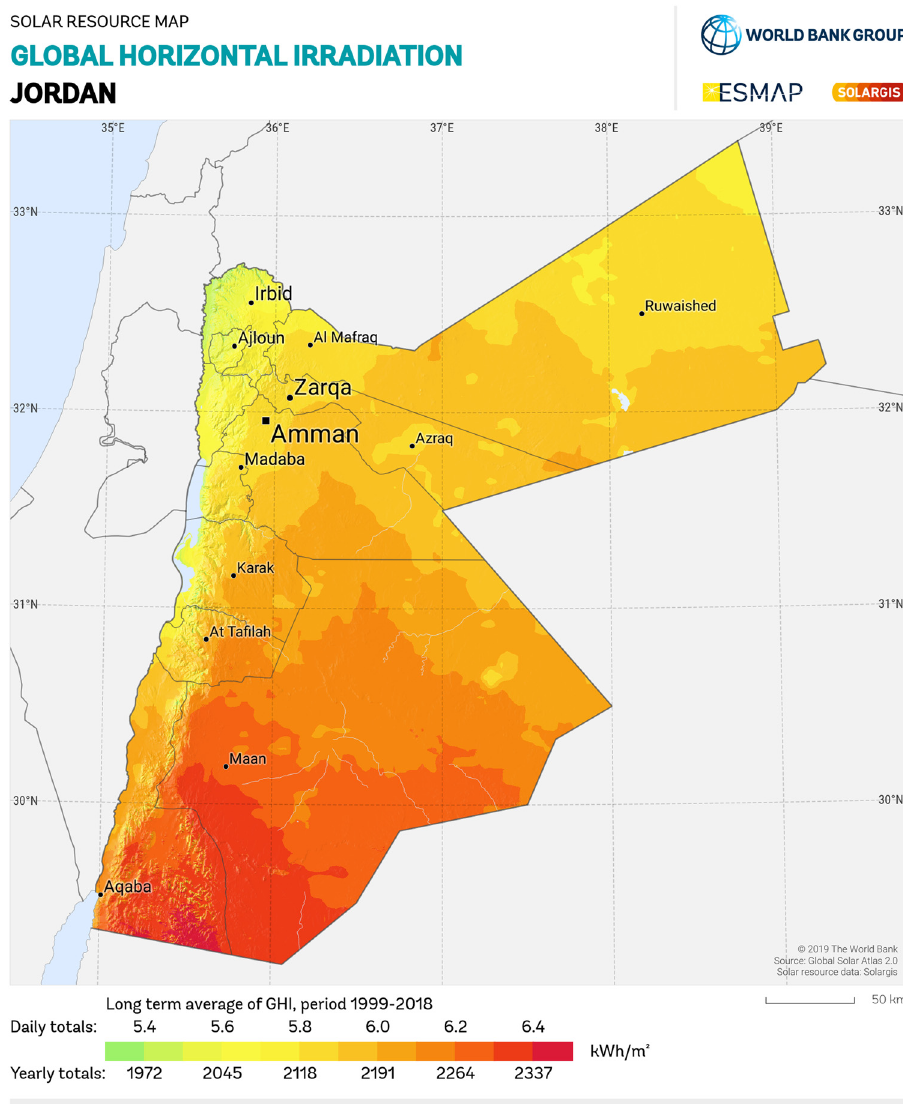
Figure 1: Global horizontal irradiation in